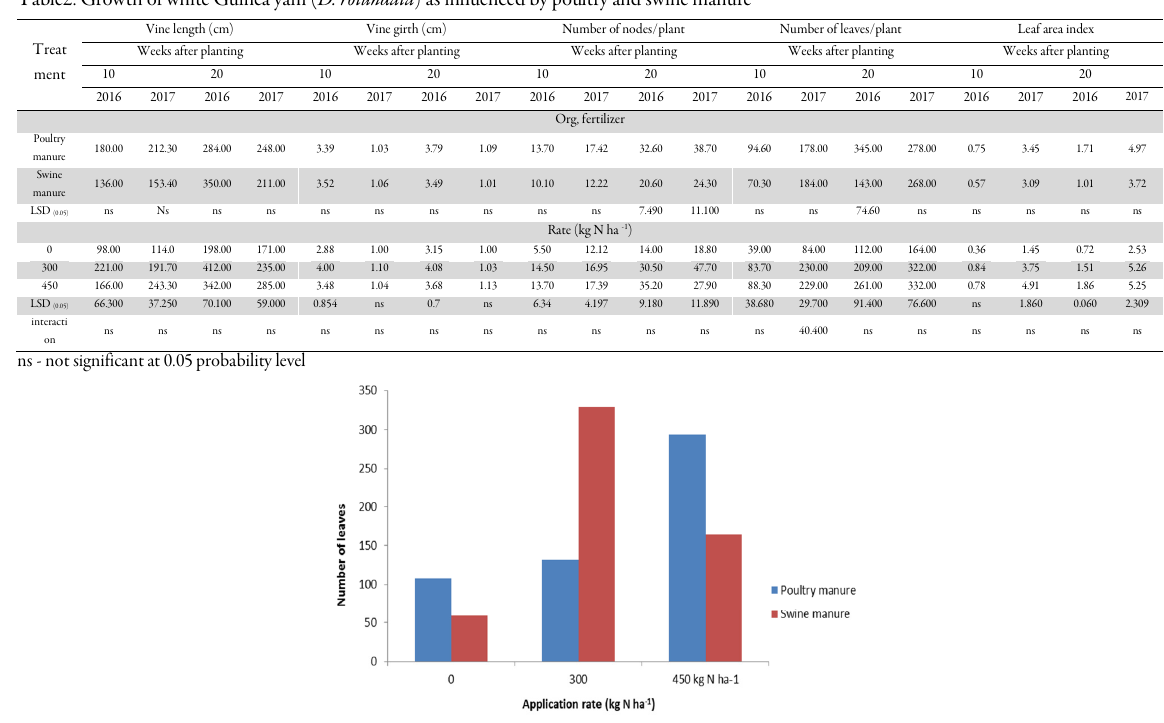
Fig. 1. Interaction of organic fertilizer types and application rates on the number of leaves at 10 WAP Leaf area index (LAI) was not significantly (p >